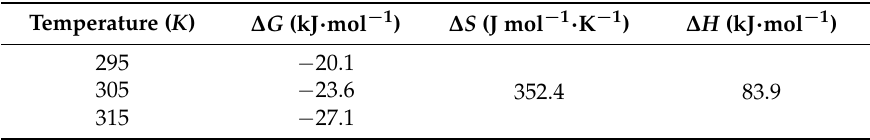
Table 4. Thermodynamic parameters for the absorption of Pd(II).